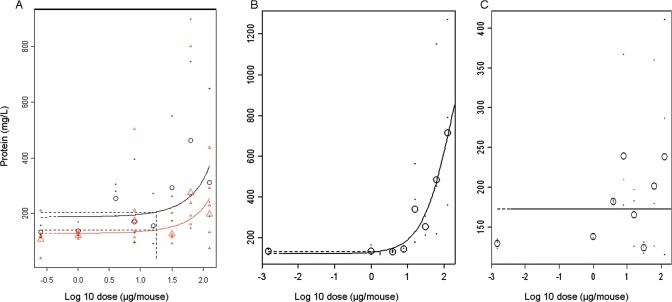
Dose-response relationships for thetotal protein amount in BALF.Dose response relationships were determined for the total amount of protein in the BALF (mg/ml) using benchmark dose modelling. A) two independent administrations of non-functionalised ZnO. The similar shape of the curves allowed pooling the data and deriving a single BMD. B) functionalised ZnO and C) Ag. The large symbols represent the (geometric) mean response of the individual responses (small symbols) in each dose group. The vertical dashed lines represent BMD respectively.